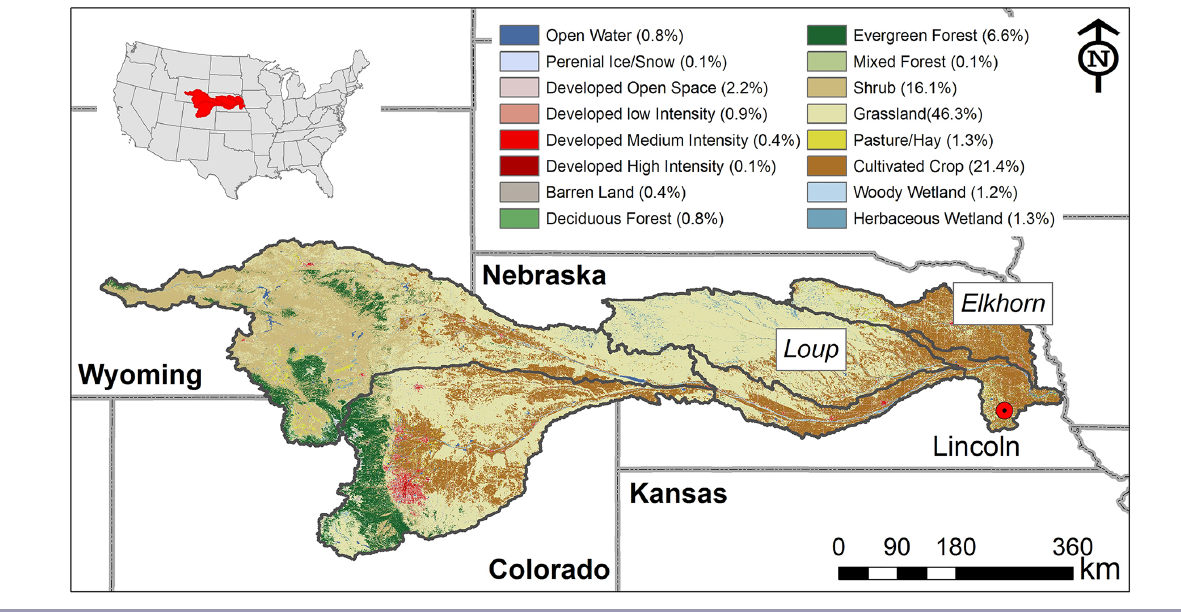
Fig. 1 . Land use map of the Platte River Watershed (including Loup and Elkhorn subwatersheds) for the year